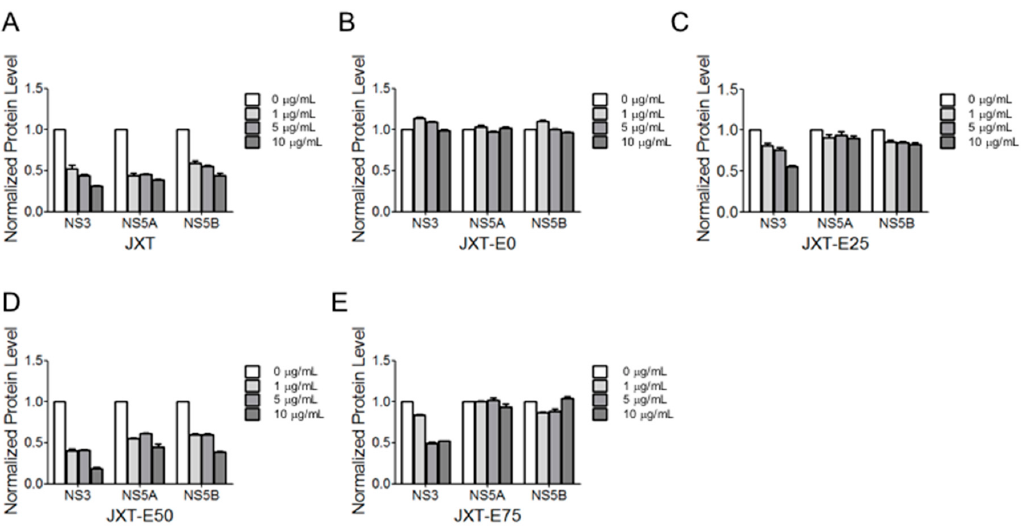
Figure 3. Quantitative results of protein expression levels of NS3, NS5A, and NS5B with treatments of ( A ) JXT; ( B ) JXT-E0; ( C ) JXT-E25; ( D ) JXT-E50; and ( E ) JXT-E75 extracts. The expression levels of NS3, NS5A, and NS5B were normalized to that of GAPDH.